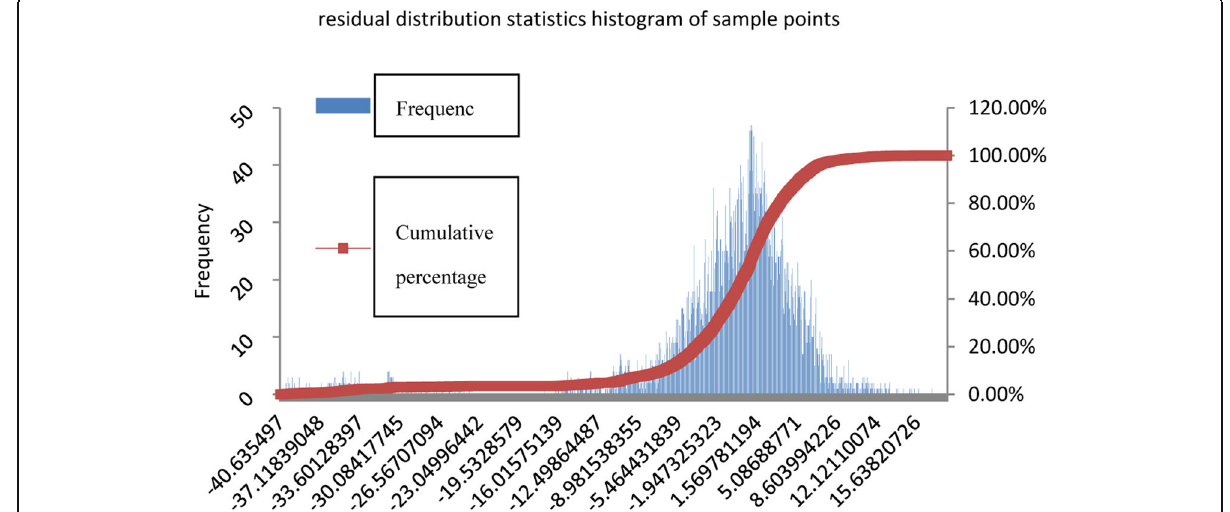
Fig. 19 Observation hole G1 – G10 time-water depth